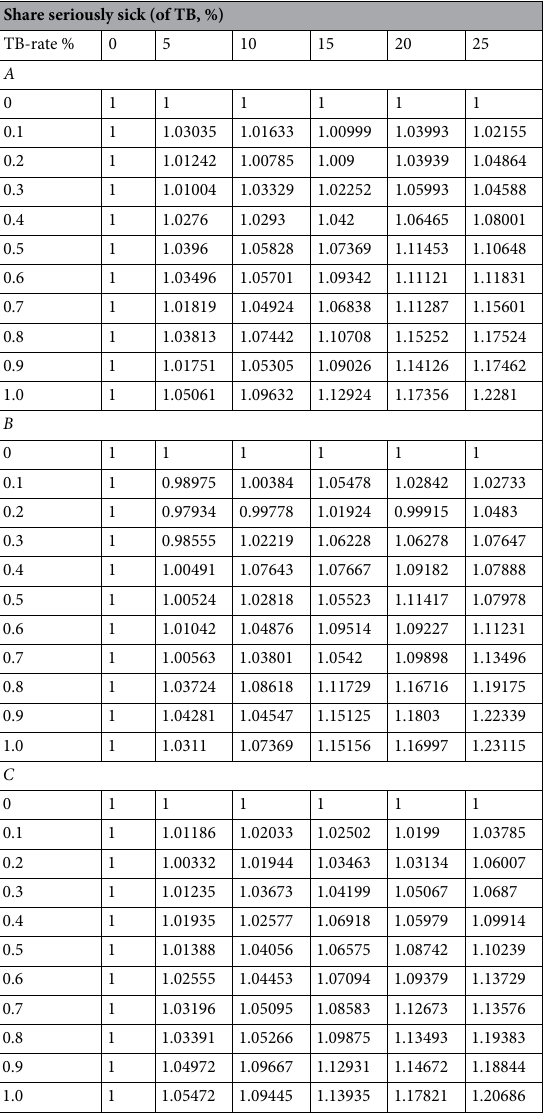
Table 2. Relative impacts of different disease-parameters on the mean of critical cases for the course of the disease. The rows reflect on TB rates ranging from 0 to 1% of the population. The columns denote the